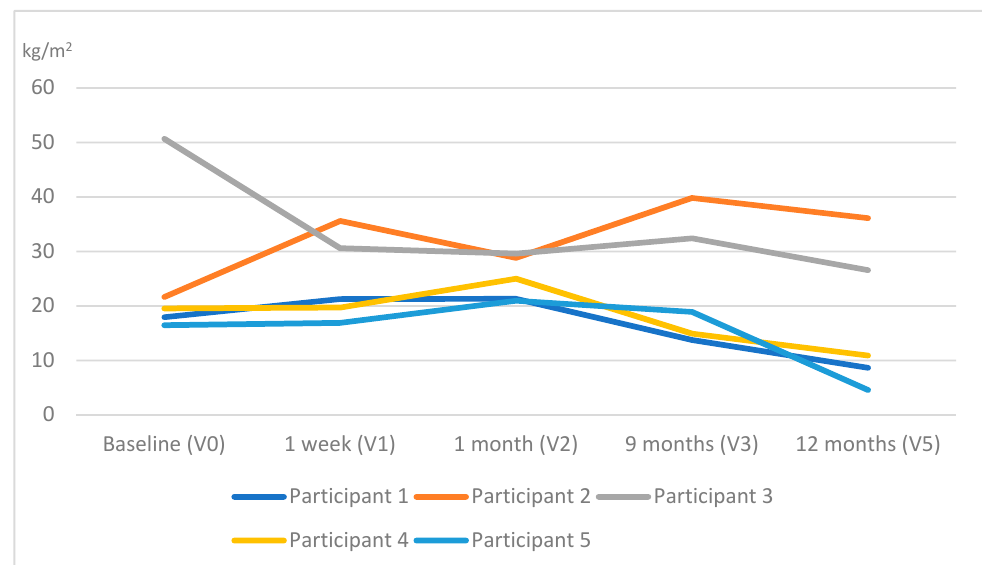
Figure 2. Evolution of the pressure pain threshold (PPT) throughout the study (the average PPT at the different locations has been calculated at each time point assessment for each participant).